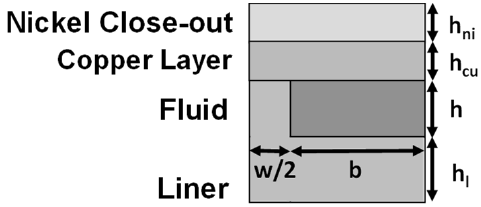
Figure 4. Geometry description of DEMO cooling jacket: cross section.